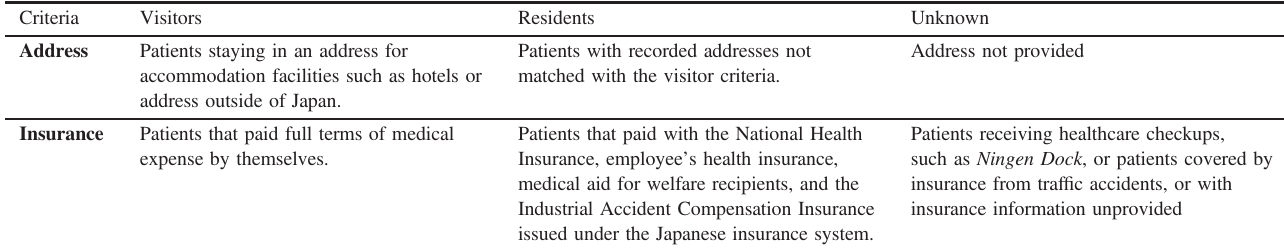
Table 1. Criteria of grouping patients into visitors or residents